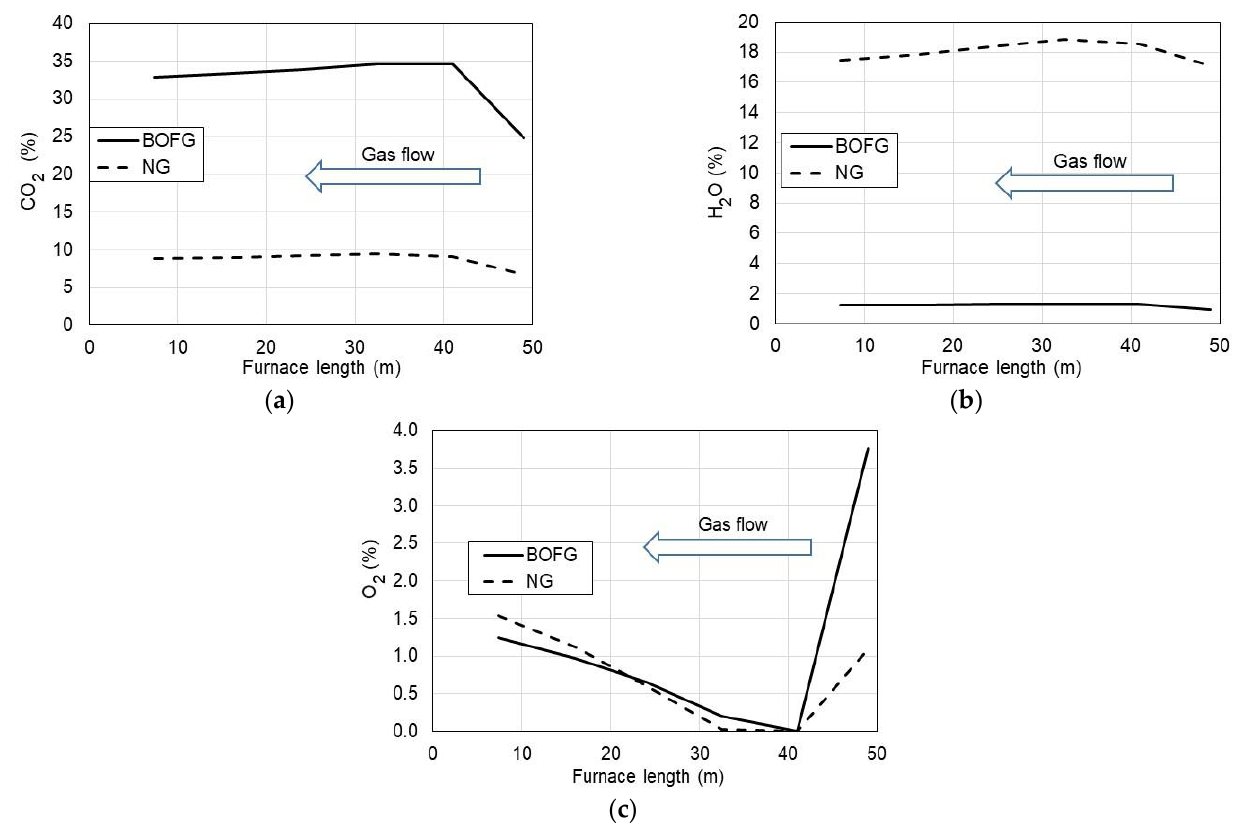
Figure 5. Combustion products CO 2 ( a ), H 2 O ( b ), and O 2 excess ( c ) volume fractions vs. length of the tunnel furnace fueled with NG and BOFG.